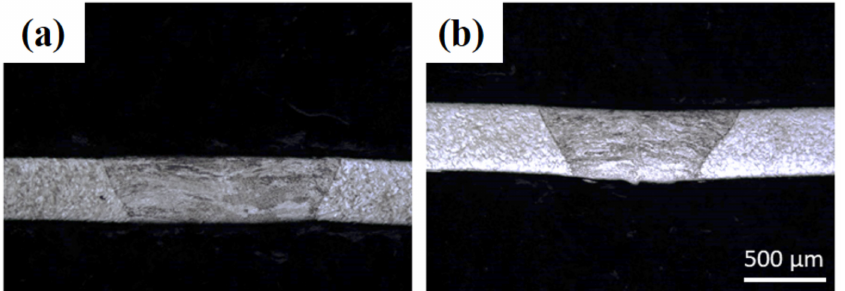
Figure 7. Optical images of 0.4 mm thick sheets’ laser weld cross-sections without powder addition and with laser power = 1000 W, gas flow rate = 5 slpm, robot tilt angle = 0 ◦ and ( a ) laser scanning speed = 2.4 m/min and ( b ) laser scanning speed = 3.0 m/min.